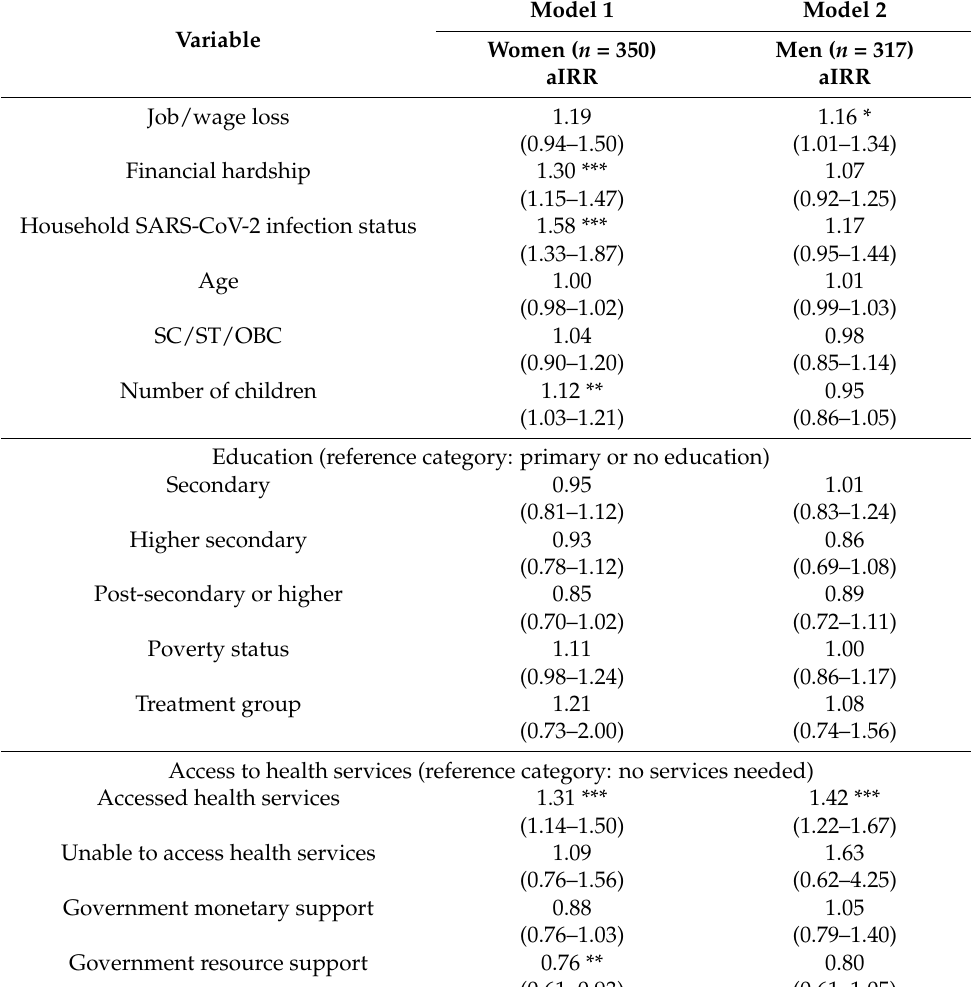
Table 4. Multivariate associations between job loss and mental health symptoms by